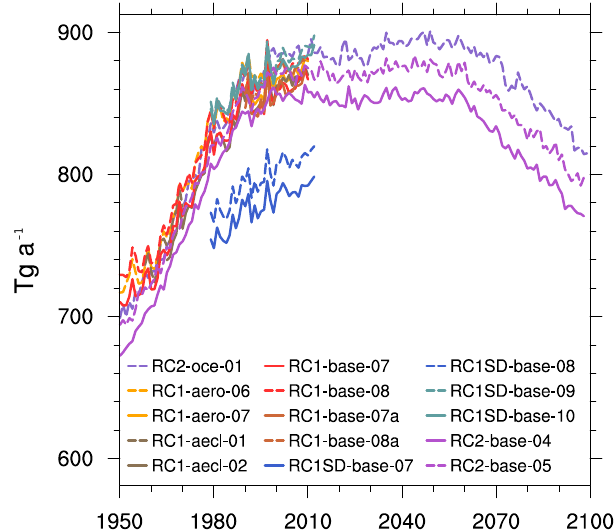
Figure 15. Globally integrated, annual dry deposition flux of ozone in Tga − 1 .